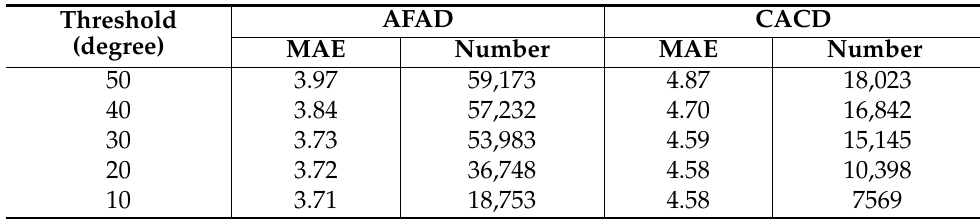
Table 3. Performance (MAE) and image numbers comparison on the AFAD [12] and CACD with different